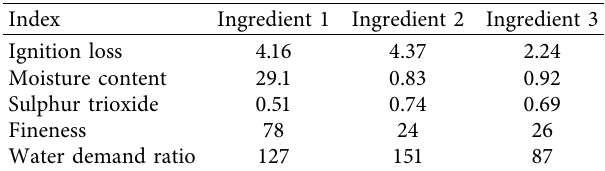
Figure 1: The structure of fly ash powder with different particle sizes. Table 1: Parameters related to the physical properties of fly